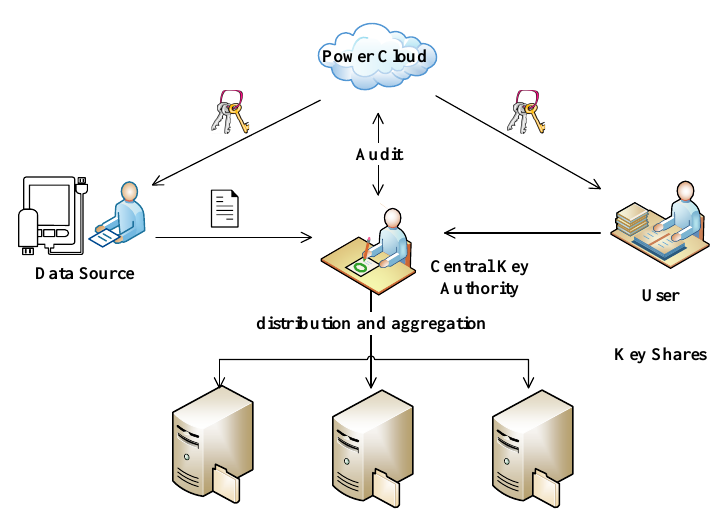
Figure 2. Power Cloud Access Control (PCAC) System Model.